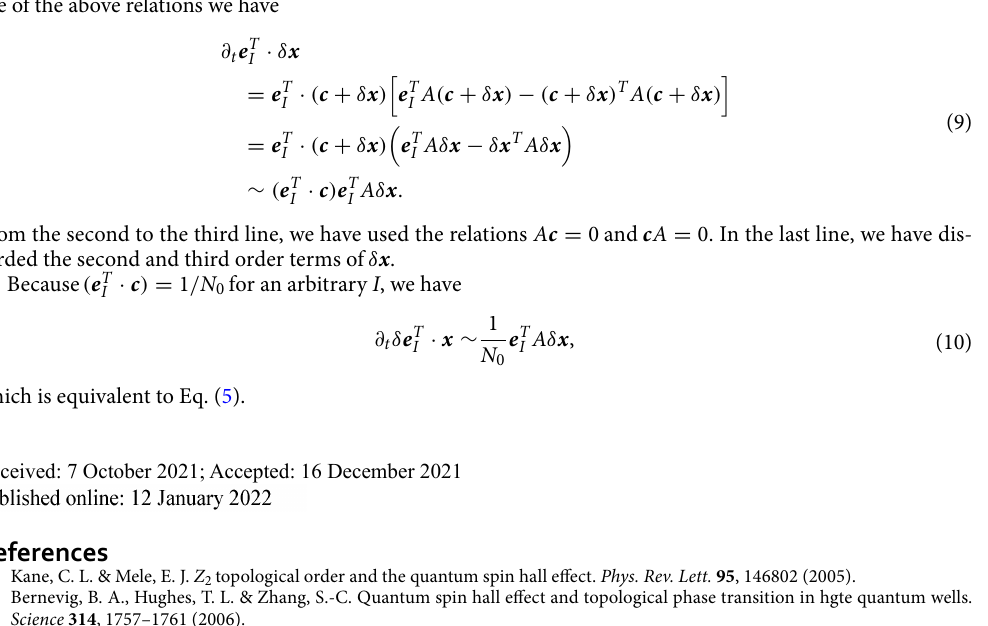
Figure 4. Time-evolution of the population density δ x ( t ) axis denotes I . ( a – f ) The time-evolution under the PBC [OBC’]. The data in panels ( a , e ) are multiplied by 5. The data are obtained by employing the fourth order Runge-Kutta method 68 with discretized time t n 0.05 . We set the initial condition so that N 0 x I ( 0 ) takes 1 (cid:31) t RK = 26 , respectively. For the other I , N 0 x I ( 0 ) takes 1. Here, N 0 is chosen so I =